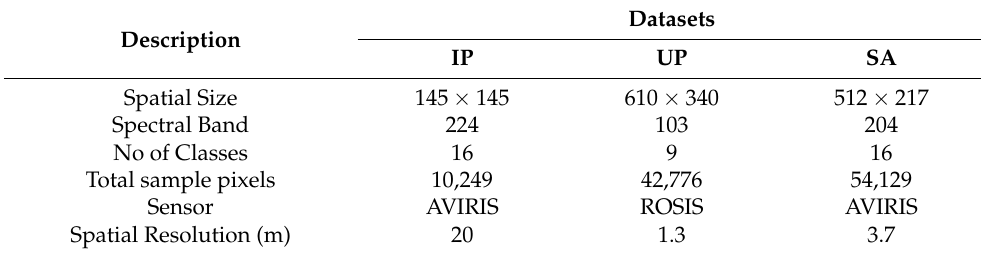
Table 1. Summary of the Characteristics of the IP, the UP, and the SA Datasets.